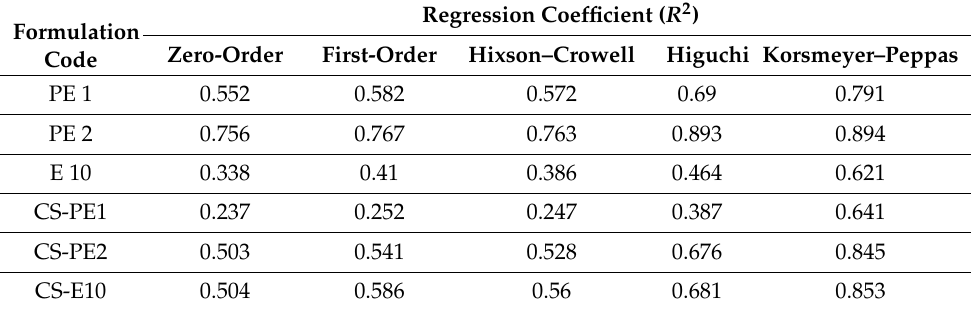
Figure 9. Comparison of in vitro drug release of non-coated and coated NPs: ( a ) E-10 and CS-E10, ( b ) PE-1 and CS-PE-1 and ( c ) PE-2 and CS-PE-2. The concentration of TA-loaded NPs in release media was 25 µ g/mL for all formulations. Data = mean ± std ( n = 3). Table 5. In vitro drug release mathematical model fitting concerning linear regression coefficient ( R 2